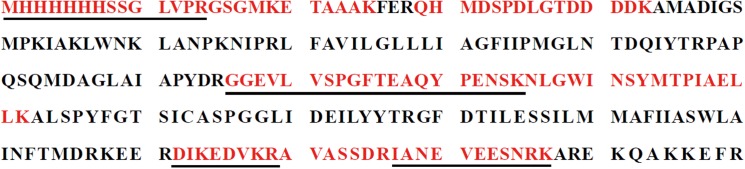
Mass spectrometry identification of recombinant protein EhaF.There were eight matched peptides (Shown in red) and four of them were matched with expected sequence in MS/MS analysis, which were in line.